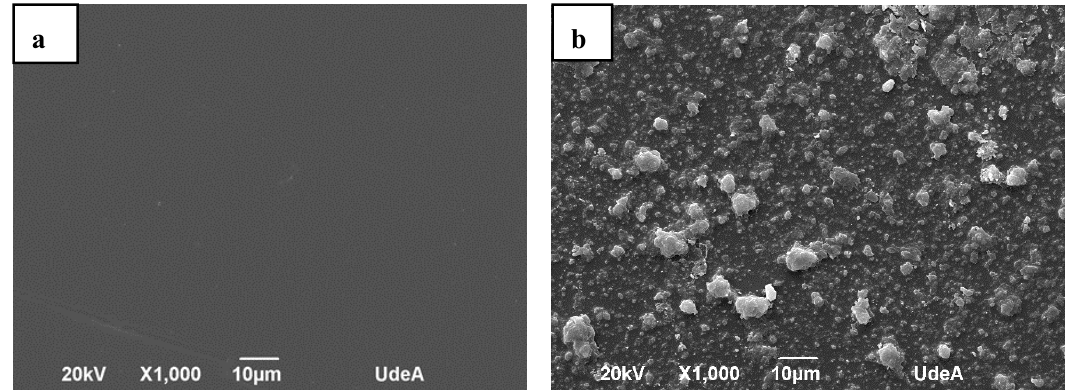
Figure 2. Scanning electron microscopy (SEM) images of ( a ) bare BGT and ( b ) TiO 2 /SiO 2 ‐ BGT.